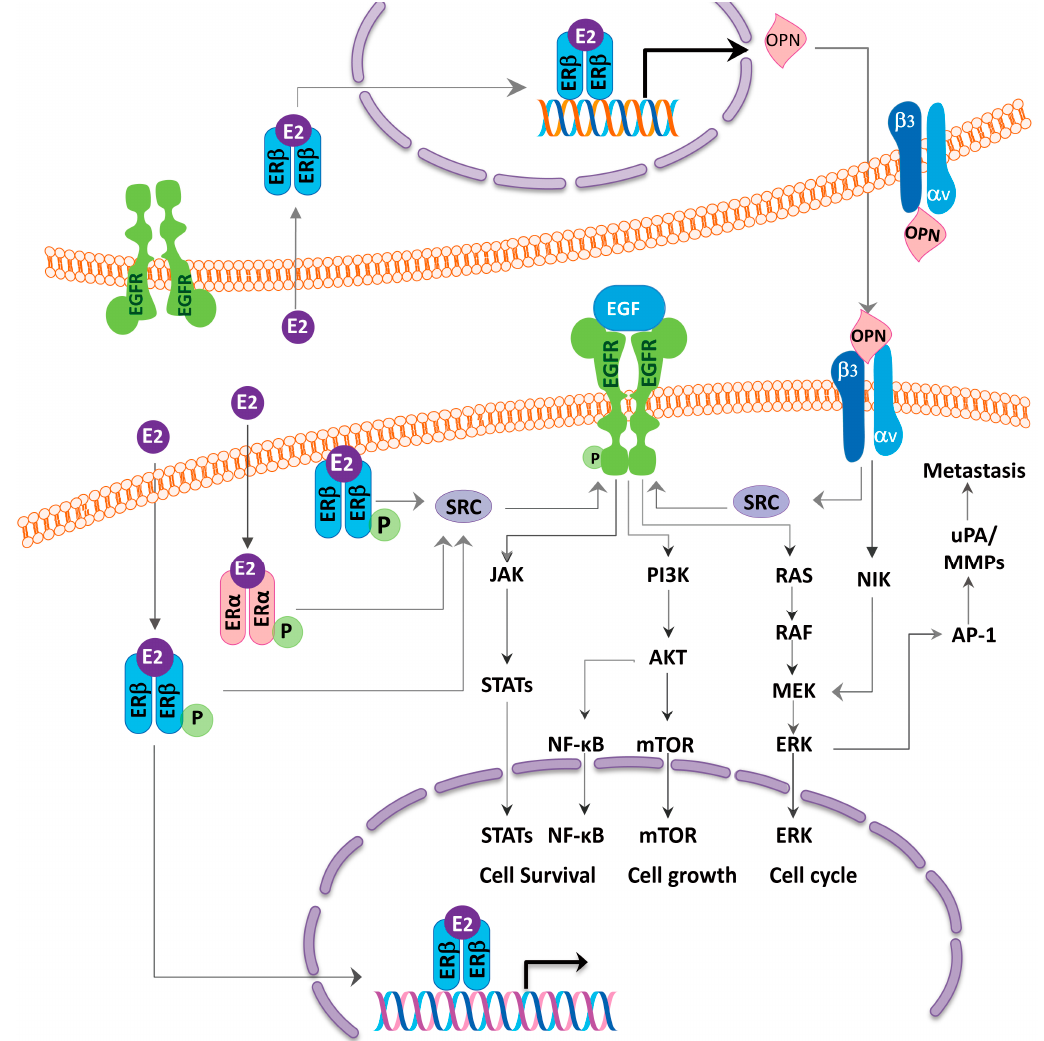
Figure 3. The schematic diagram illustrating the mechanisms of how the estrogen receptor (ER) coordinates with the epidermal growth factor receptor (EGFR) to affect the cell growth in the lung adenocarcinoma. Estrogen stimulates the steroid receptor coactivator (SRC) protein, which in turn, activates the EGFR signaling pathways. In addition, estrogen upregulates the osteopontin (OPN) expression and promotes the lung cancer cell migration via the MEK/ERK signaling pathway. The SRC and OPN contribute to the cross-talk between the ER and the EGFR.